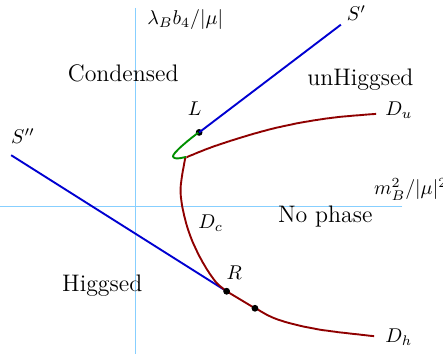
Figure 36 . Phase diagram for φ u < x B . Recall that the effective potential is unbounded from 6 below in this case so that the ‘phases’ displayed here are dominant metastable phases when they exist. To the right of the red curve the effective potential is monotonic so no meta-table phases exist. The blue lines are second order transitions and the green curve is a first order transition between metastable phases. To the ‘right’ of the red curve no metastable phases exist. We have restored the | µ | dependence of the phase diagram by rescaling m 2 and λ B b 4 by appropriate powers B of | µ |